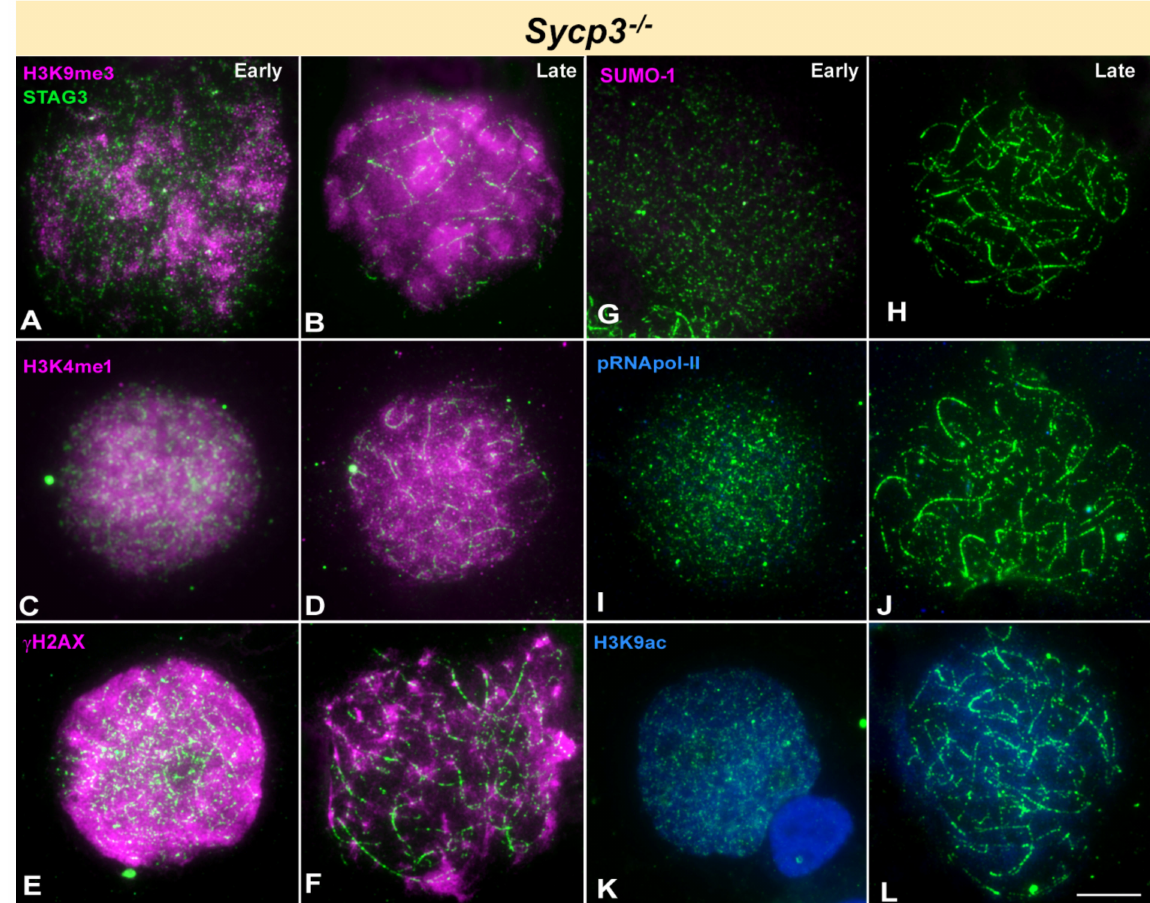
Figure 6. Immunolocalization of STAG3 (green) and epigenetic markers of silencing (pink) or transcription activation (blue) in Sycp3 knockout mice. Cells have been divided into early or late stages. STAG3 appears in all stages as discontinuous or fragmented filaments, representing cohesin axes. ( A , B ). H3K9me3 distribution is not homogeneous in the nucleus in early stages ( A ) but it concentrates in some large areas. In mid stage ( B ) it appears more spread in the nucleus, with local accumulations lacking a clear relationship to specific chromosomal regions. ( C , D ). H3K4me1 covers almost the whole chromatin from early to late stages. ( E , F ). γ H2AX localized to the whole nucleus in early stages. In late stages ( F ) it seems to concentrate in more discrete but large foci. ( G , H ). No SUMO-1 labelling is observed in spermatocytes at any stage. ( I , J ). No labelling of pRNApol-II is observed in any spermatocyte. ( K , L ). A faint signal of H3K9ac is detected in the nucleus in all stages. Scale bar: 10 µ